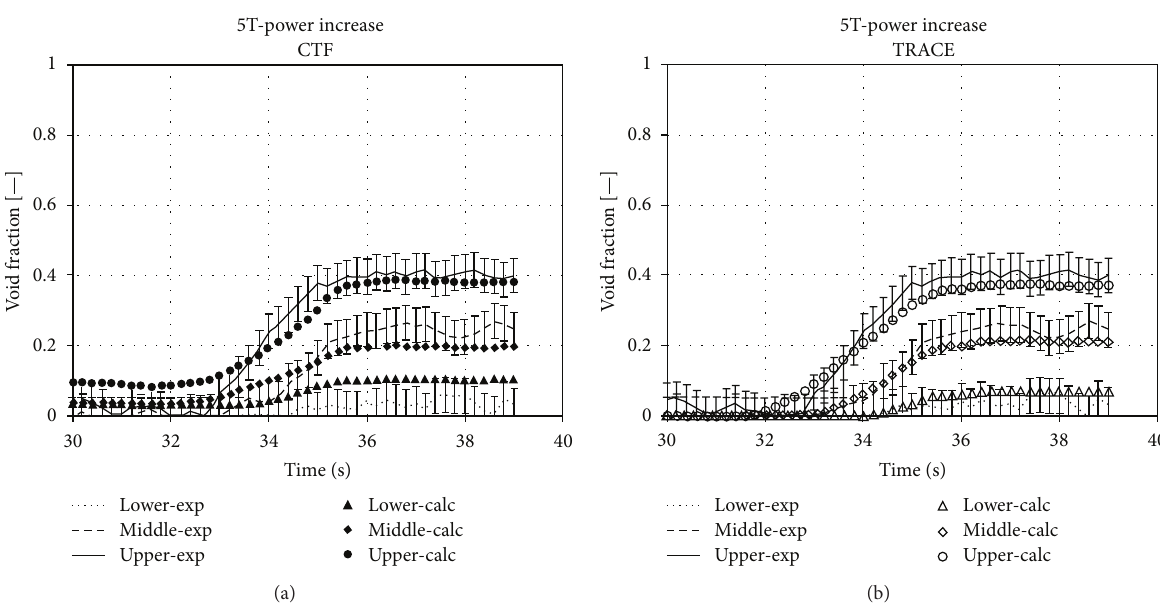
Figure 4: CTF (a) and TRACE (b) predictions of void fraction in bundle type B5 during power increase